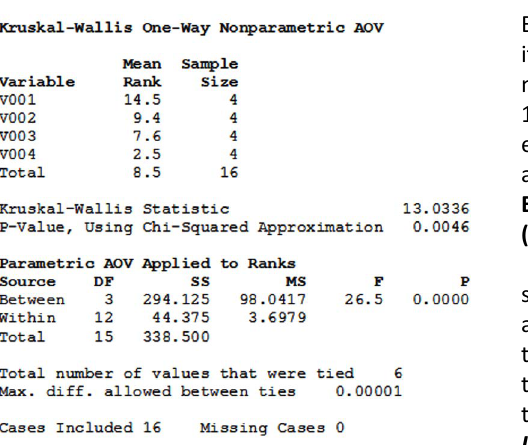
Fig. 4. Kruskal-Wallis Test for four lotions with Lactobacillus acidophilus ATCC® 4356 against Propionibacterium acnes ATCC® 11827.